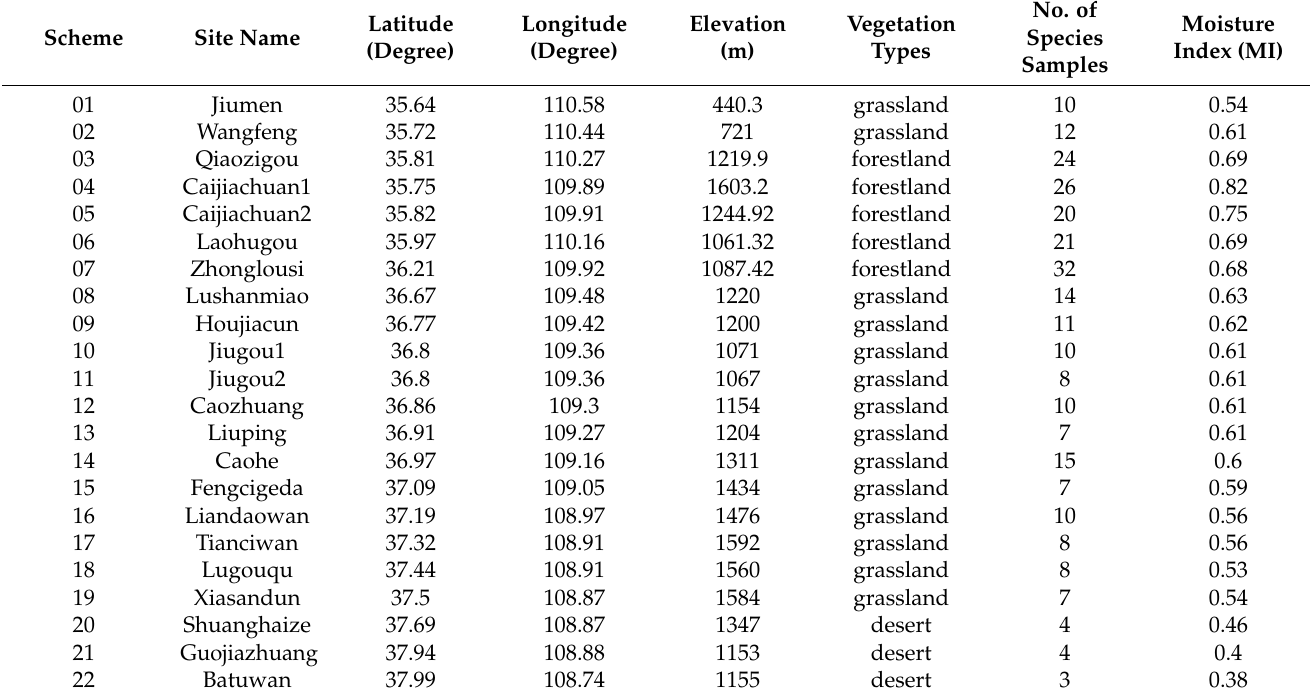
Table 1. Characteristics of the studied sites from the China Loess Plateau